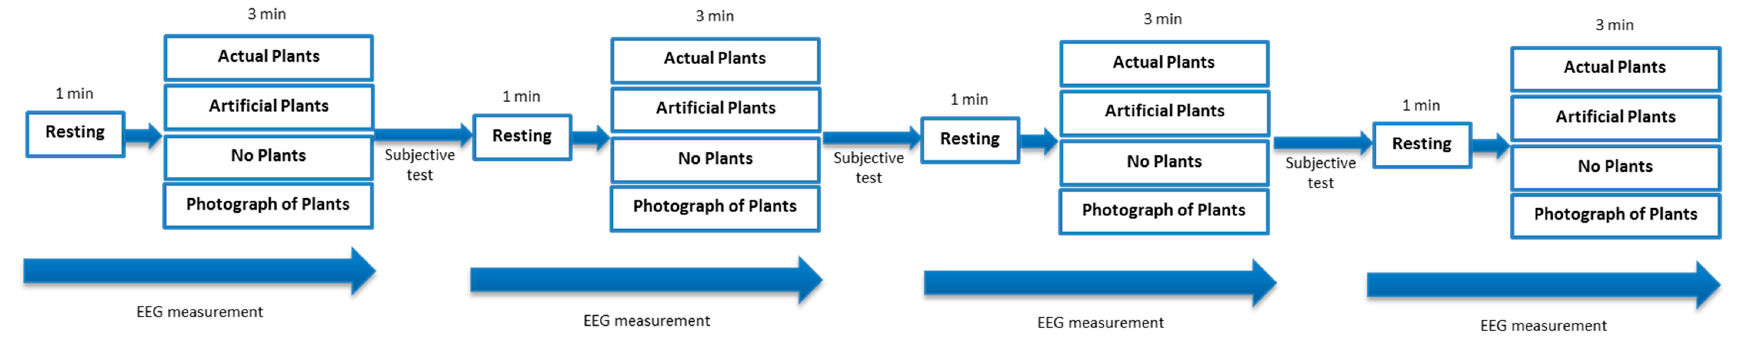
Figure 3. Experimental protocol used to assess the effects of exposure to four stimuli. The responses of the participants were assessed via electroencephalography (EEG) measurements and subjective tests.